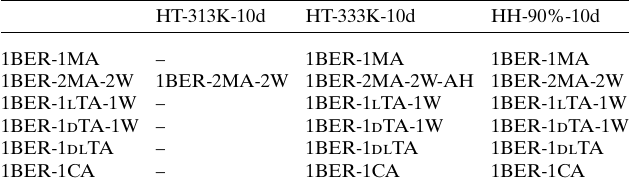
Table 4 Stability of the synthesized products kept at high humidity and high temperature.